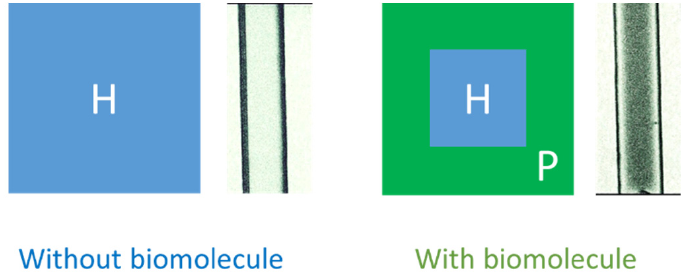
Figure 2. Optical mechanism and images from a non-polarized optical microscope of dye-doped liquid crystal (DDLC) microfluidic chips of a biosensor in both the presence and absence of biomolecules.